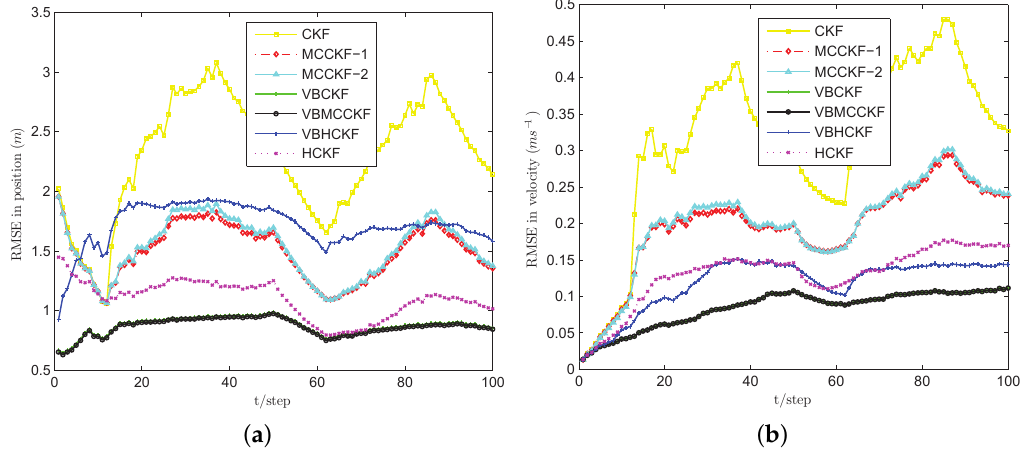
Figure 3. RMSE performances of different filters under Case B. ( a ) position; ( b ) velocity.